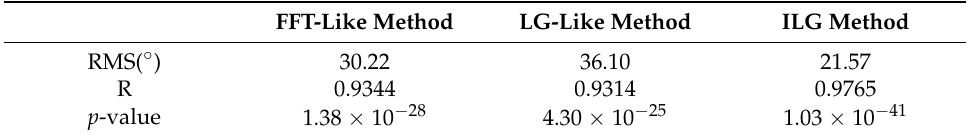
Table 1. The results of general statistics between wind directions obtained by different retrieval methods and ECMWF reanalysis data for 62 images.